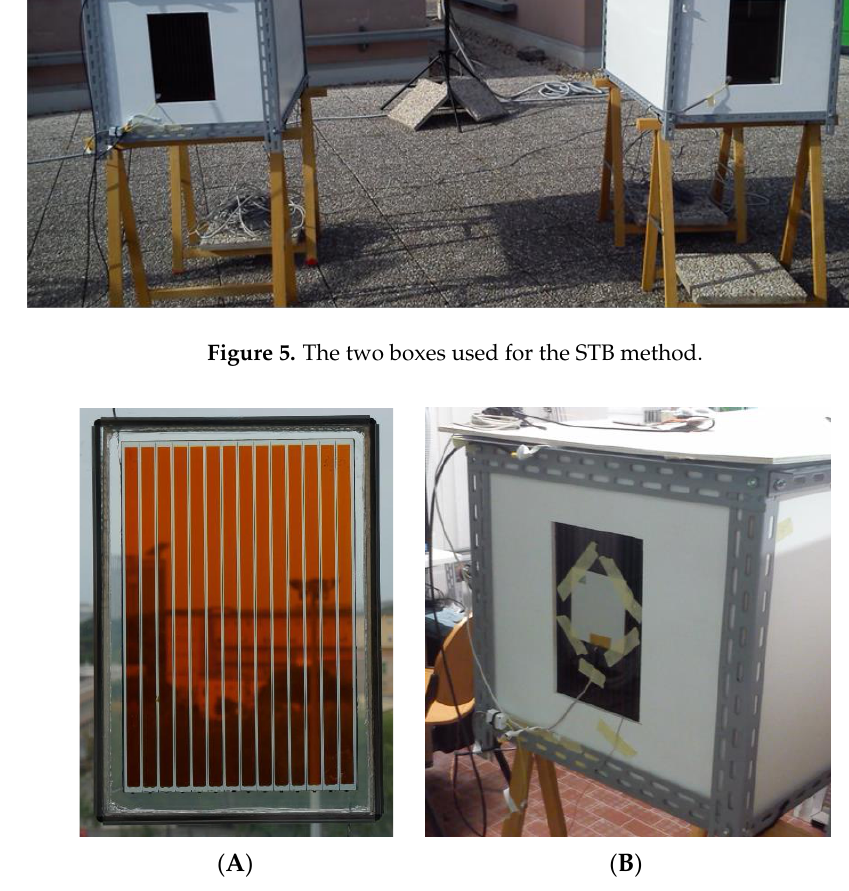
Figure 5. The two boxes used for the STB